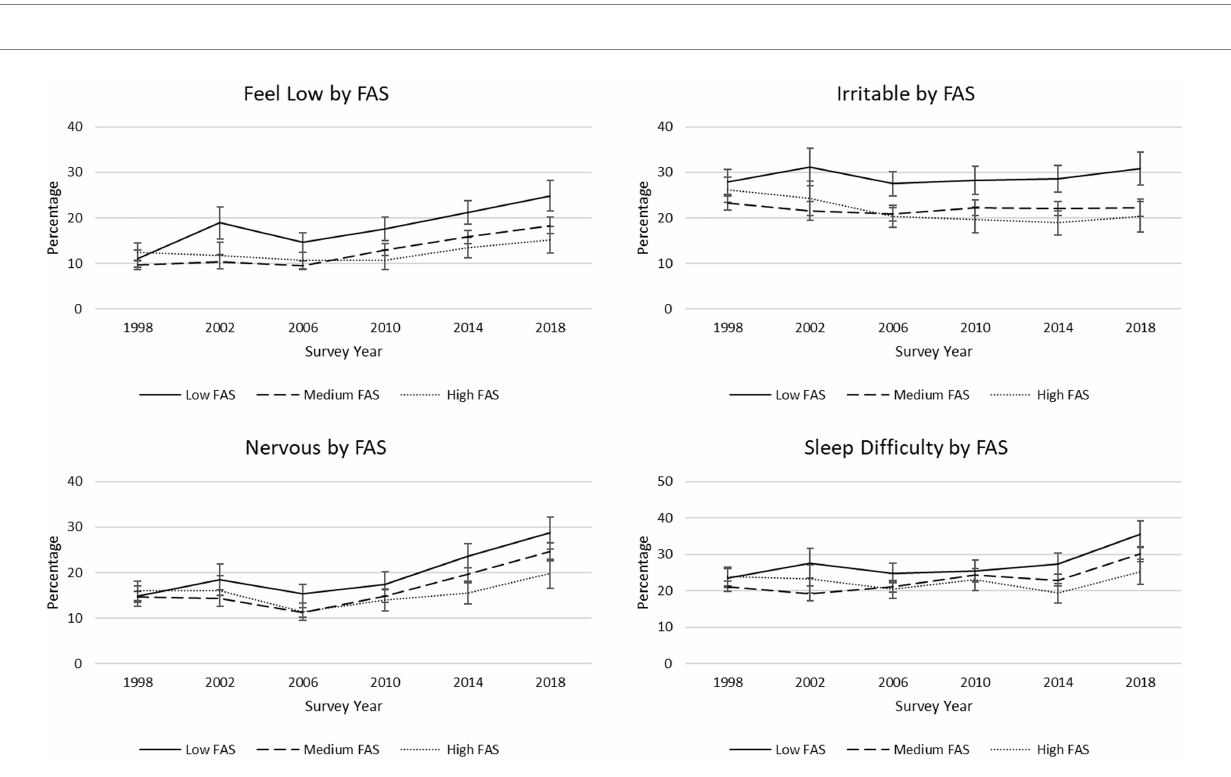
FIGURE 3 Trends in percentages of reported psychological symptoms, by Family Affluence Scale (FAS). 95% confidence intervals are